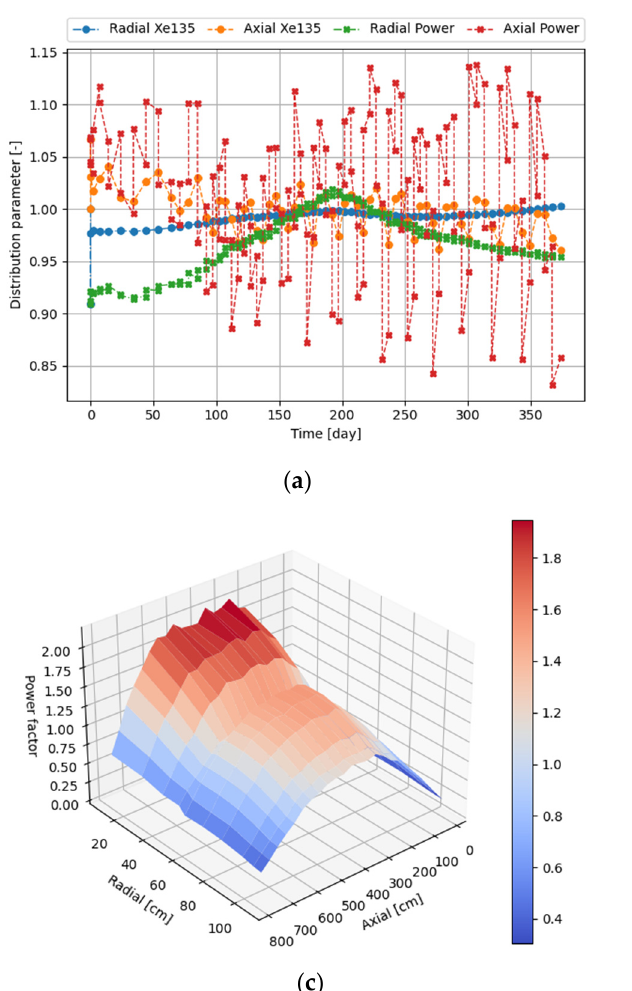
( b ) Figure 7. Result of operation strategy St_solid, in refined timestep simulation: ( a ) distribution parameters; ( b ) total peaking factor (top) and evolution of Keff (bottom). There is a noticeable improvement compared with the results in the first scheme since the power peaking factor oscillates below the value of 3.0 but still is 50% higher than in